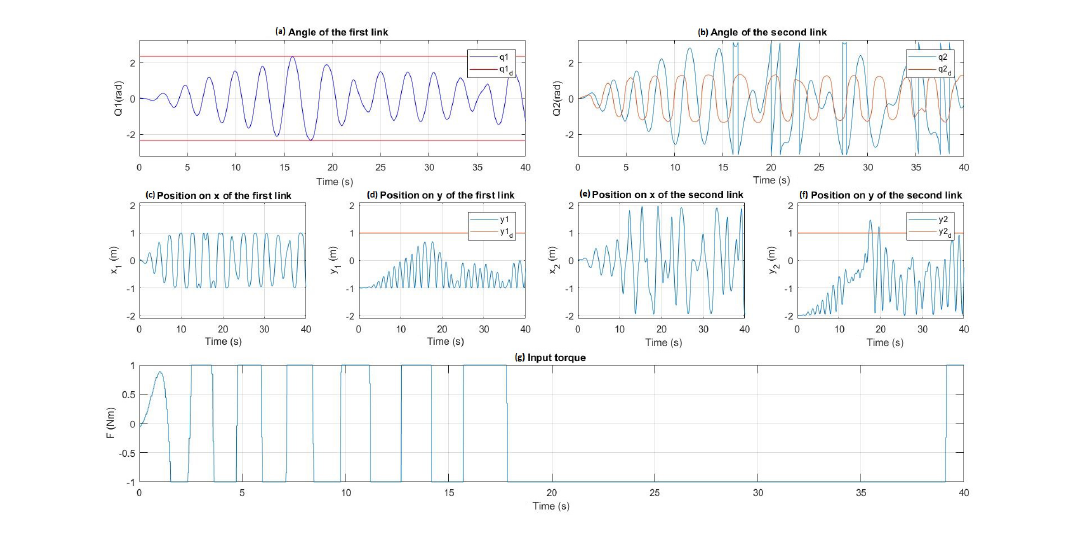
Figure 4. Results of the conventional PD controller to the swing-up problem. In the first row, the positions of the angle of the first ( a ) and the second ( b ) links are shown in radians. The red line in ( a ) is the moment when the balancing controller starts to control for the balancing problem. The red line in ( b ) is the desired angle of the second link. In the second row, there are the positions on x ( c ) and y ( d ) of the first link and on x ( e ) and y ( f ) of the second link. The red lines in ( d ) and ( f ) are the goal height ( t = 1 m) of the swing-up problem. In the last row, the input torque is represented ( g ).